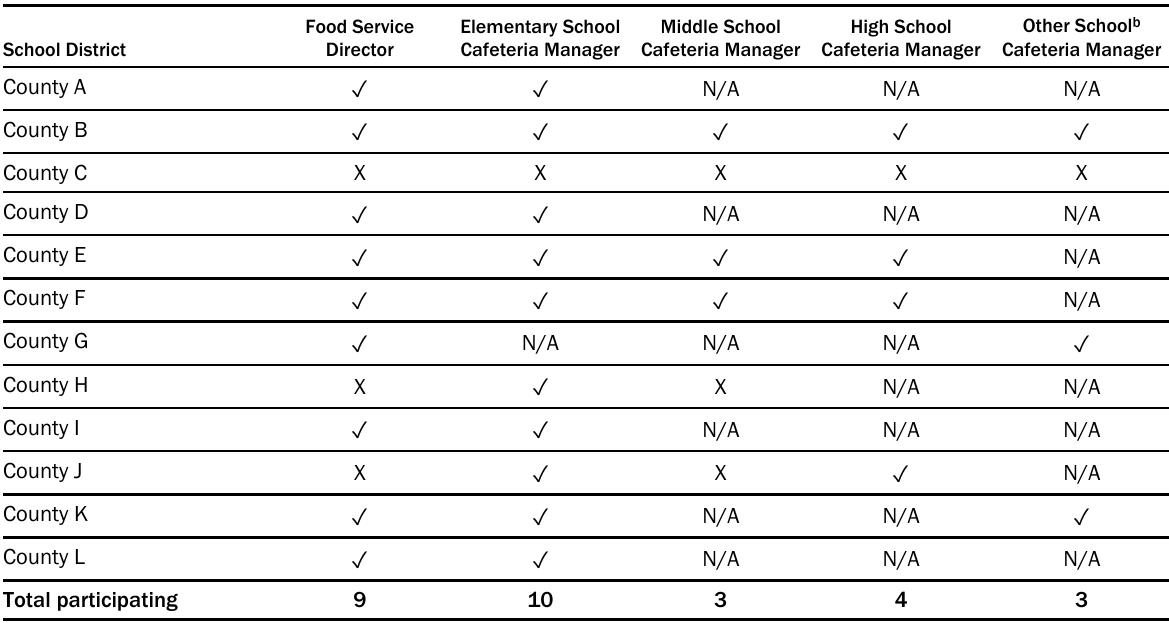
Table 1. Participating Food Service Directors and Cafeteria Managers by District and School Level a ( n =28